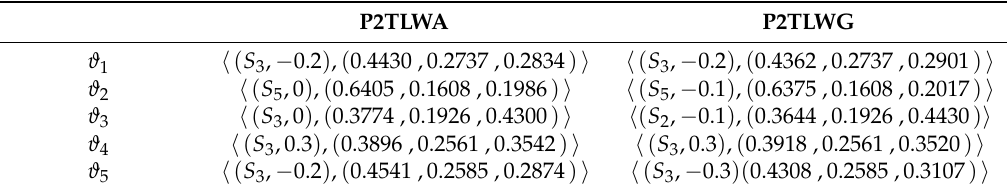
Table 9. The fused values by using some picture 2-tuple linguistic number (P2TLN) aggregation operators.